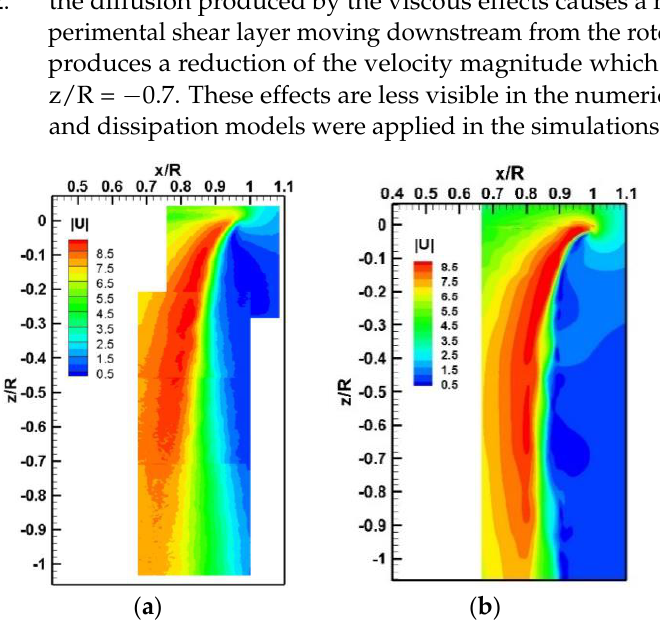
Figure 8. PIV ( a ) and numerical ( b ) ensemble average velocity magnitude colour maps.